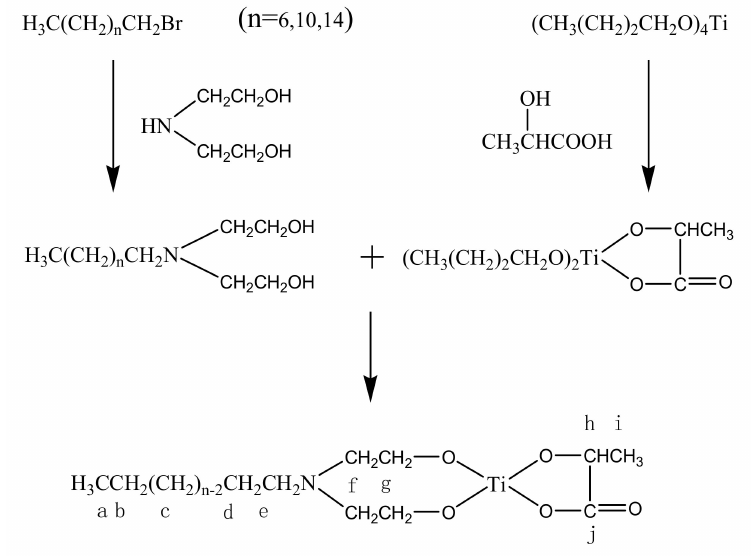
Figure 6. Synthesis route to conjugated titanate bonding